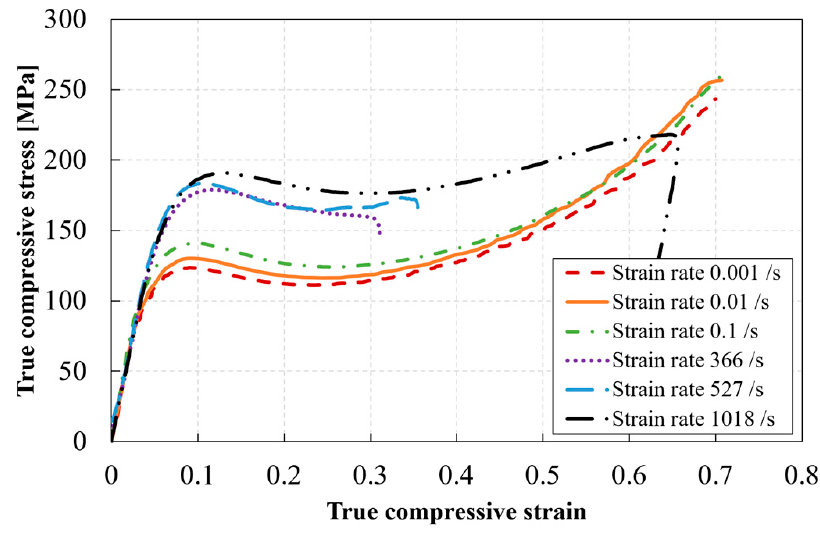
Figure 14. Example of the compressive true stress–true strain curves at different strain rates for the RTM6 epoxy. Table 2. Summary of the results of the RMT6 epoxy resin during compression at different strain